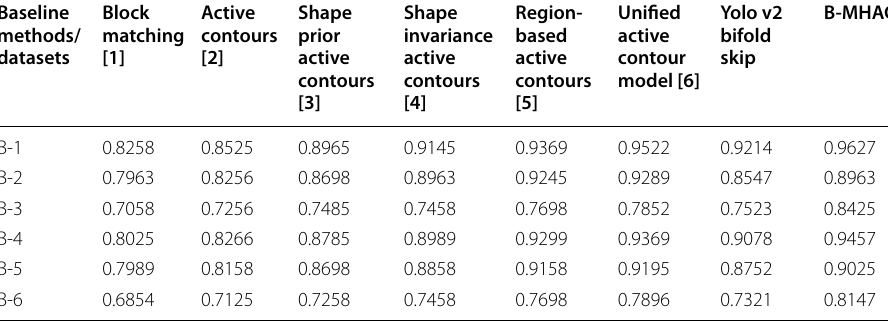
Table 6 B-MHAC vs similar models on mAP Baseline